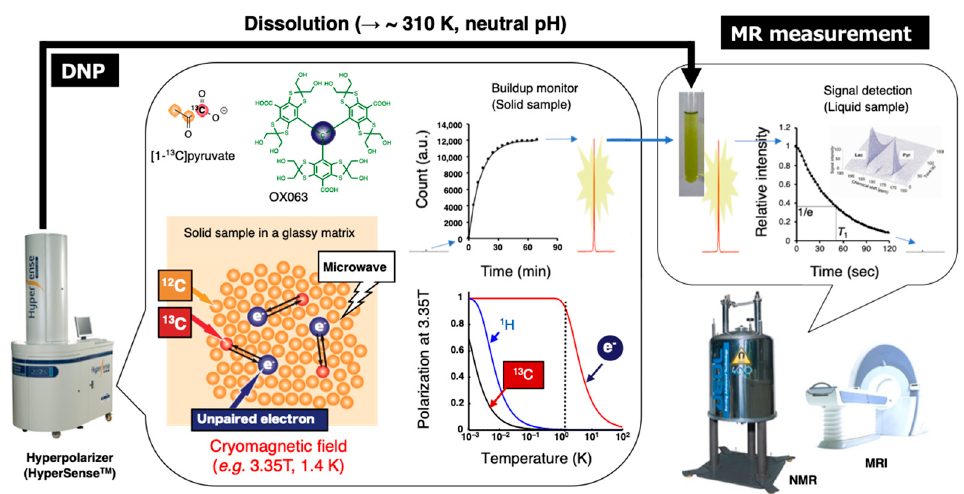
Figure 9. Schematic representation of hyperpolarized 13 C NMR/MRI by dissolution DNP. The 13 C-labeled molecular probe with the radical agent (OX063) in a glassy matrix is conditioned in the cryomagnetic field (e.g., 3.35 T, 1.4 K) on the hyperpolarizer (HyperSense TM ). The continuous microwave irradiation preferentially excites the unpaired electron spin under the conditions and following spin transfer for the 13 C nuclei in the molecular probe, thereby buildup the 13 C NMR signals. The solid sample is quickly dissolved in the superheated solvent to warm up around biological temperature and pH, and then subjected to the NMR or MRI to collect the hyperpolarized spectroscopic data (HP-NMRS) or imaging (HP-MRI).